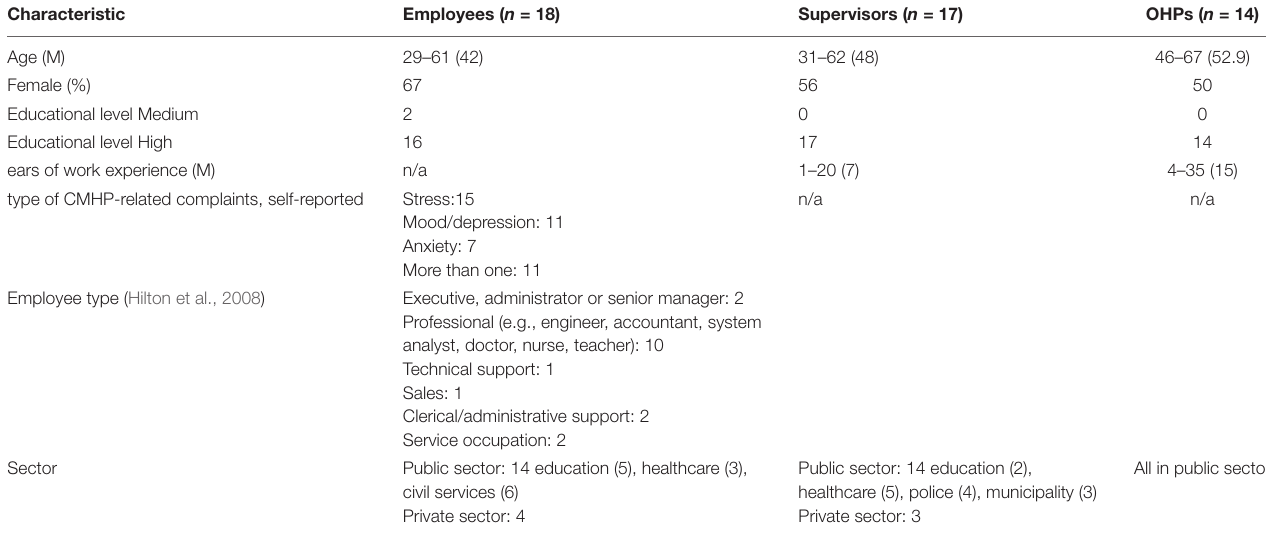
TABLE 1 | Participant